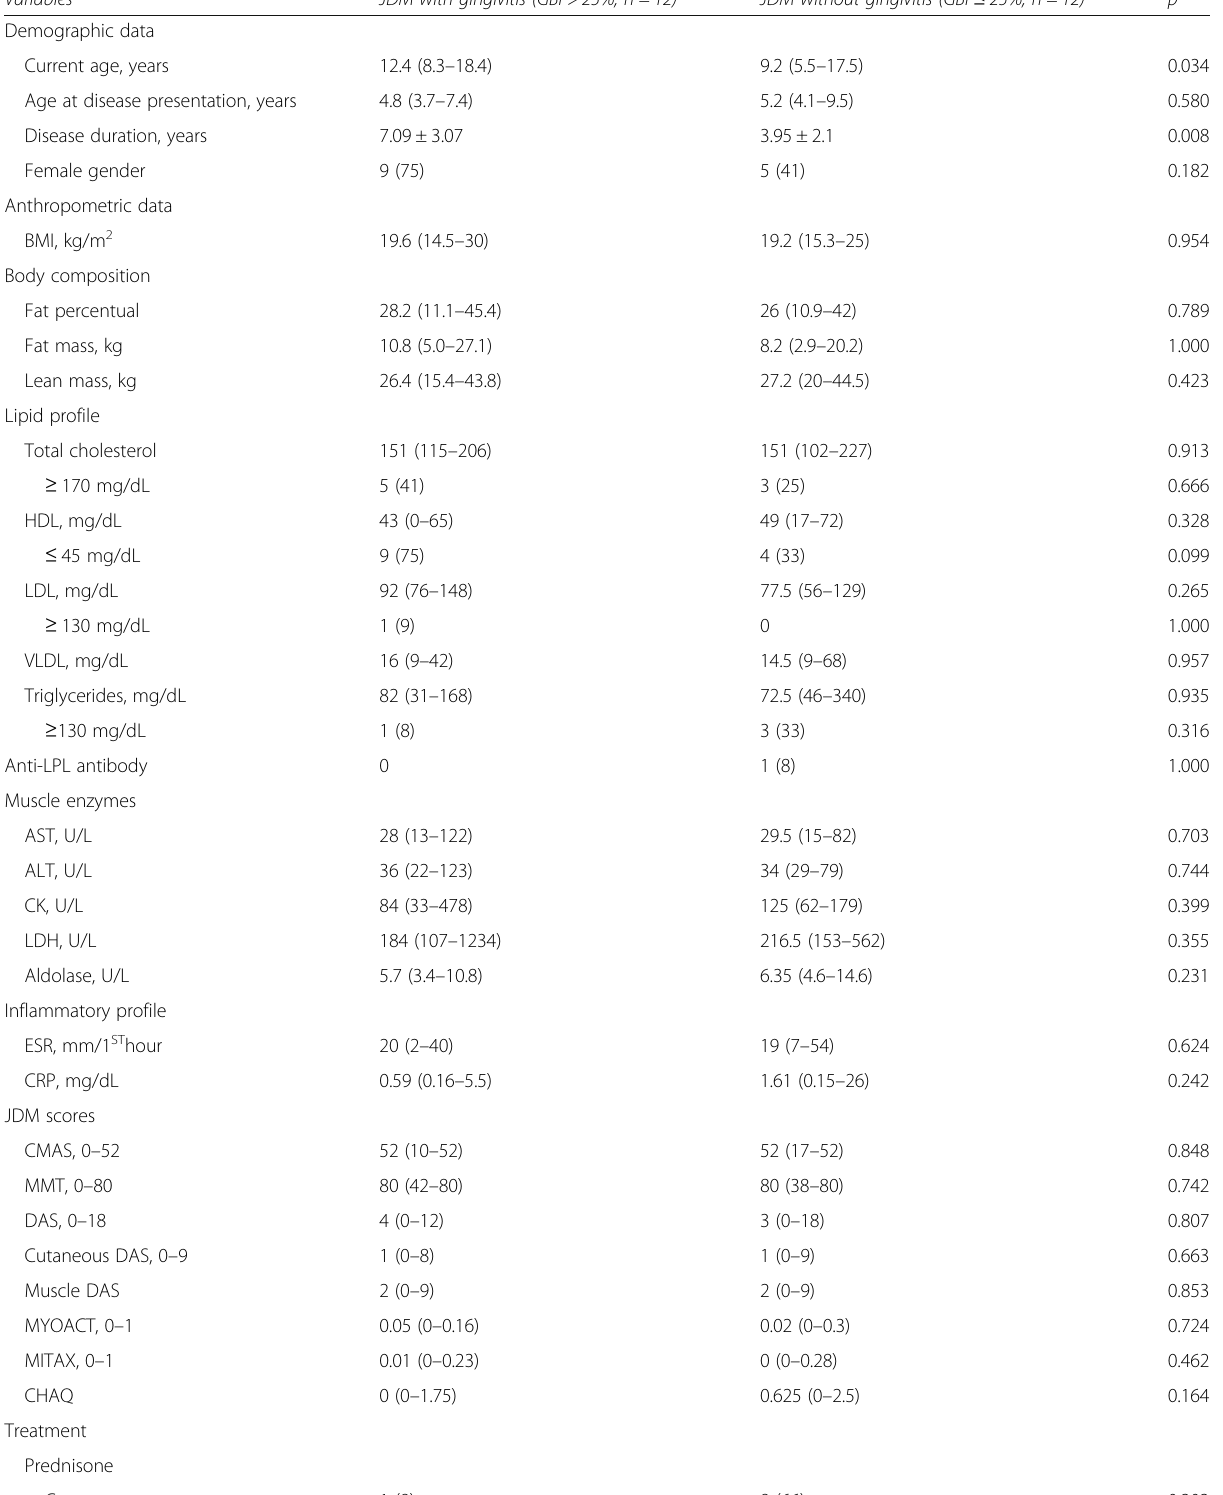
Table 3 Demographic and anthropometric data, body composition, laboratorial findings, juvenile dermatomyositis (JDM) scores and treatment in JDM patients with and without